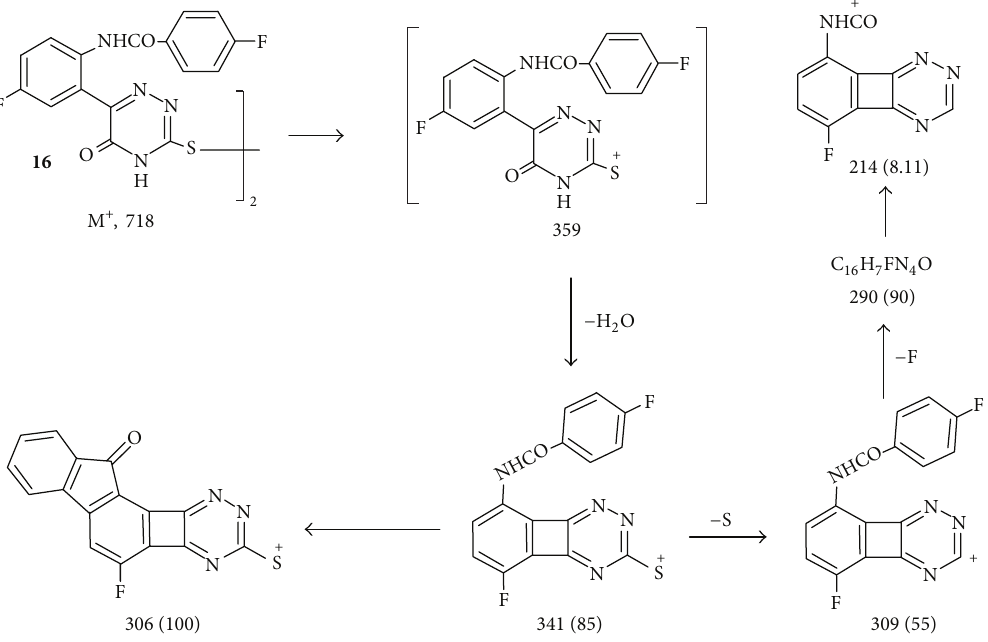
Scheme 10: Mass fragmentation pattern of compound 16 .